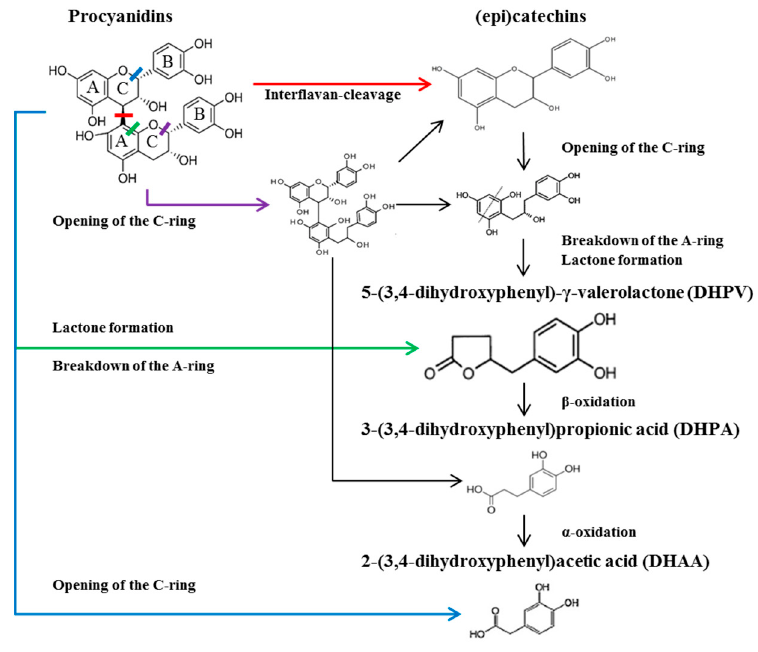
Figure 1. Microbial catabolism of procyanidins.